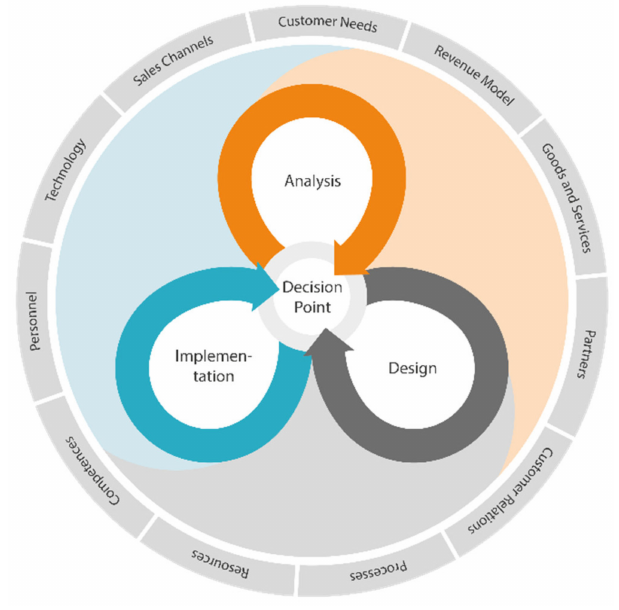
Figure 10. A reference process for designing smart service systems, translated from